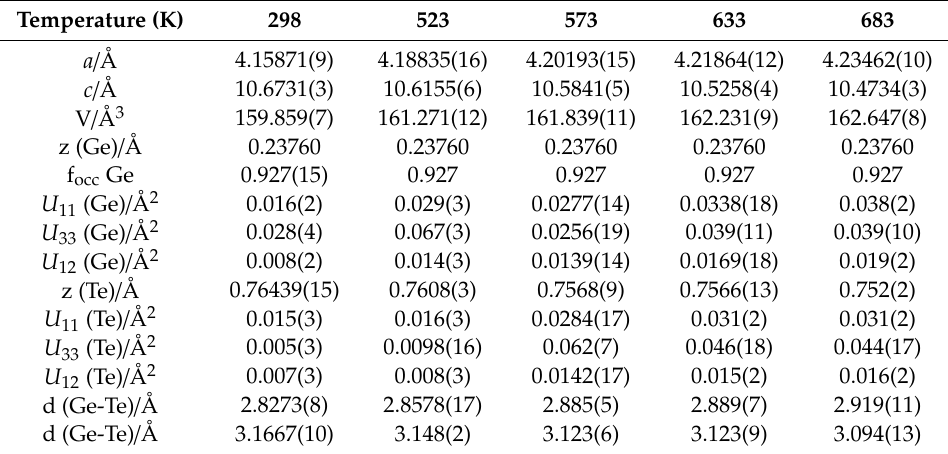
Figure 2. Neutron powder di ff raction (NPD) profiles after the Rietveld refinement of the rhombohedral crystal structure at ( a ) 523 K and ( b ) 683 K. Table 1. Main structural parameters after the Rietveld refinement from NPD data for GeTe in the rhombohedral ( R3m ) phase (hexagonal